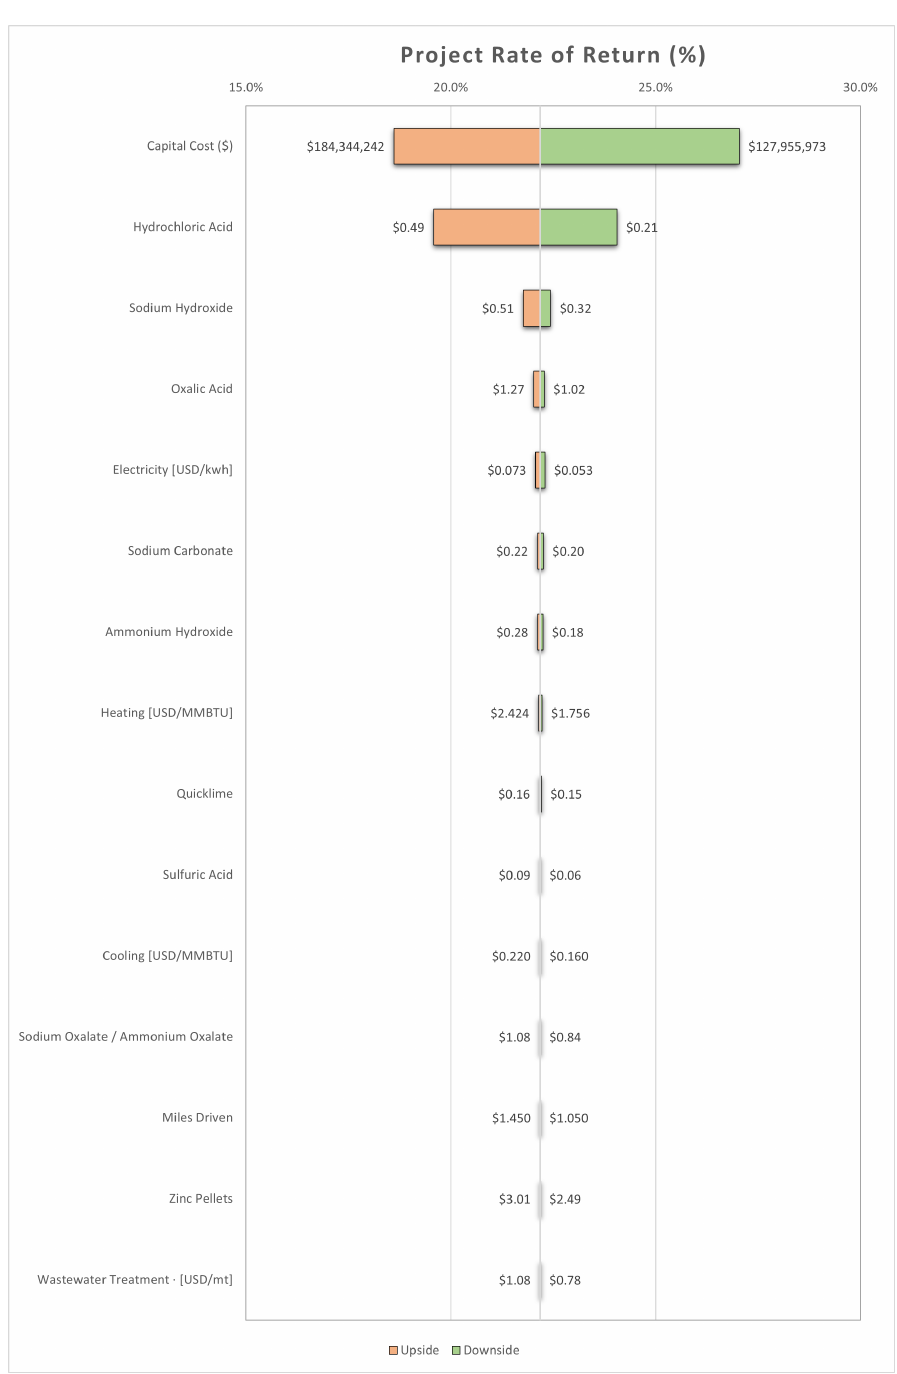
Figure 7. Tornado plot showing the sensitivity of several key input factors on the project rate of return. Current pricing, magnet element-only